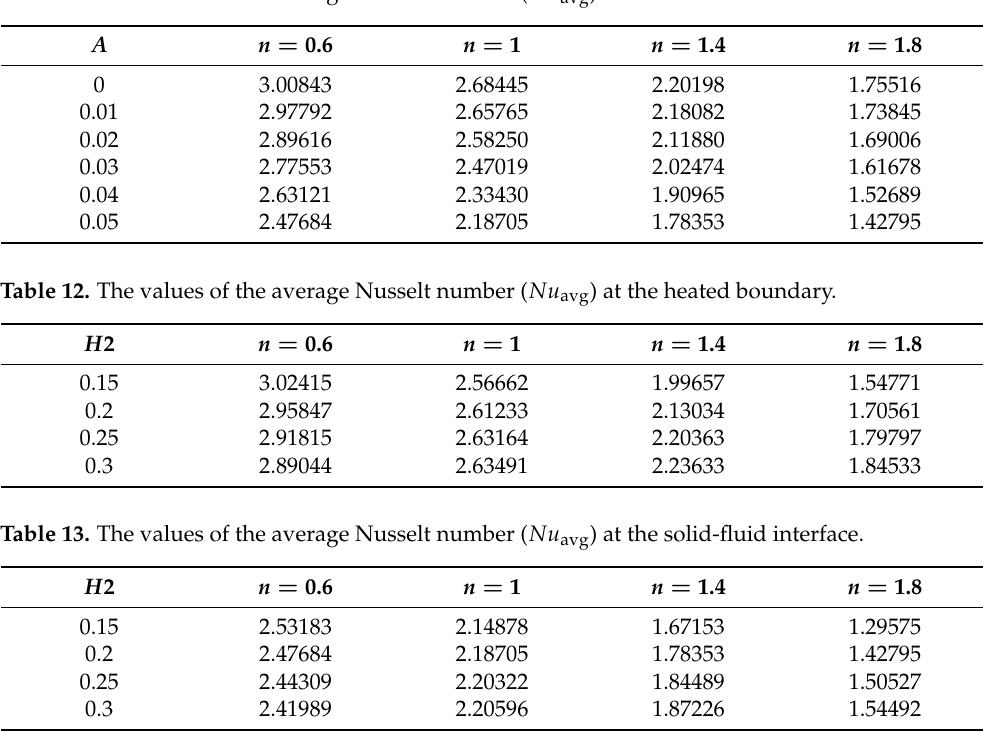
Table 11. The values of the average Nusselt number ( Nu avg ) at the solid-fluid interface.